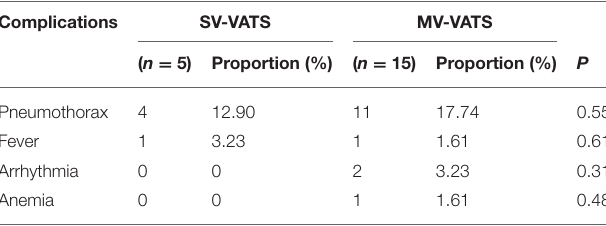
TABLE 3 | Perioperative complications after 1:2 propensity score matching.